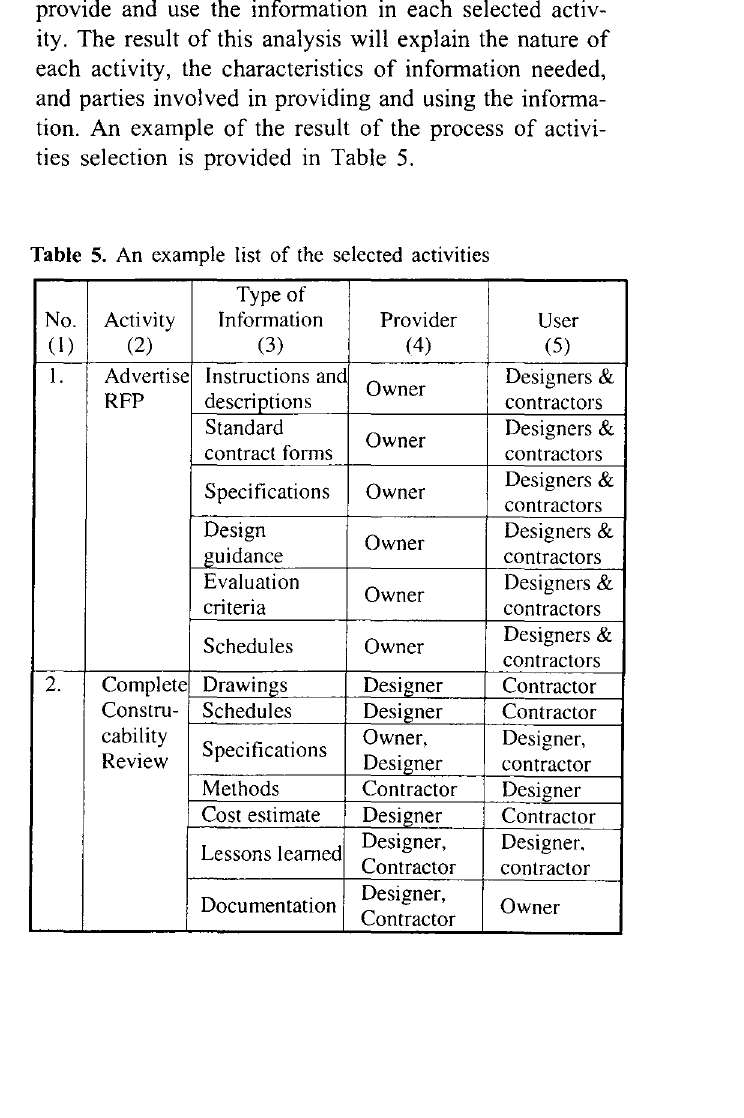
Table 5. An example list of the selected